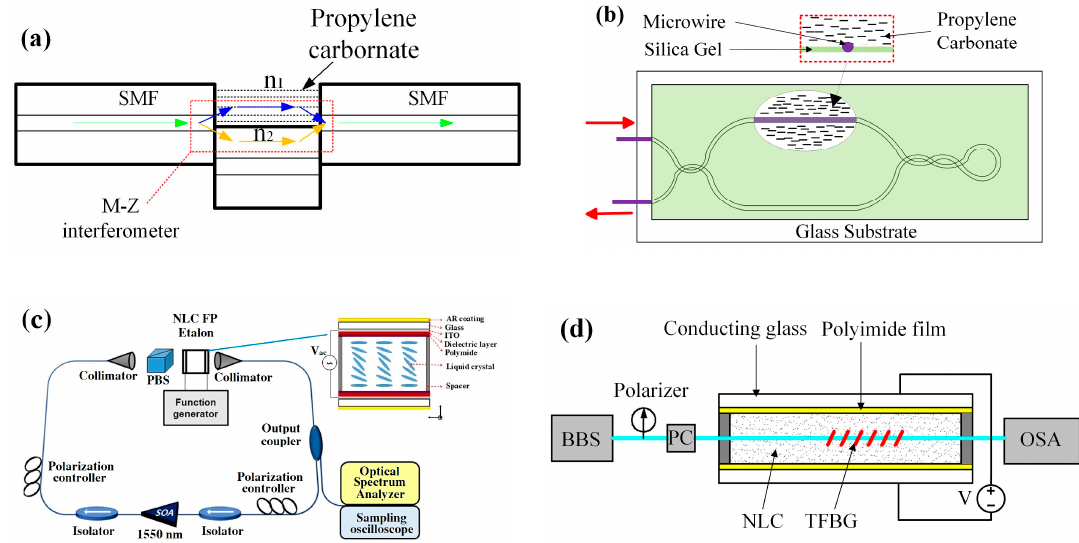
Figure 14. ( a , b ) Senor probe based MZI and propylene carbonate [98,99], ( c ) sensing area and